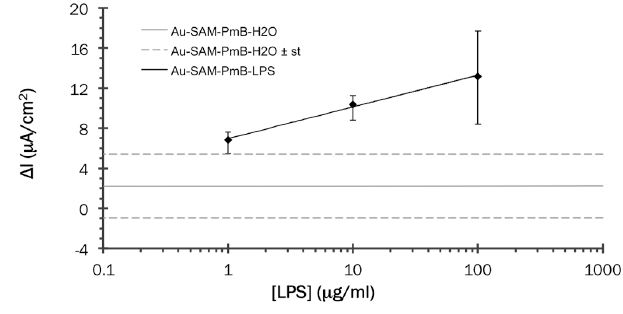
Figure 8. Quantitative detection of LPS by the